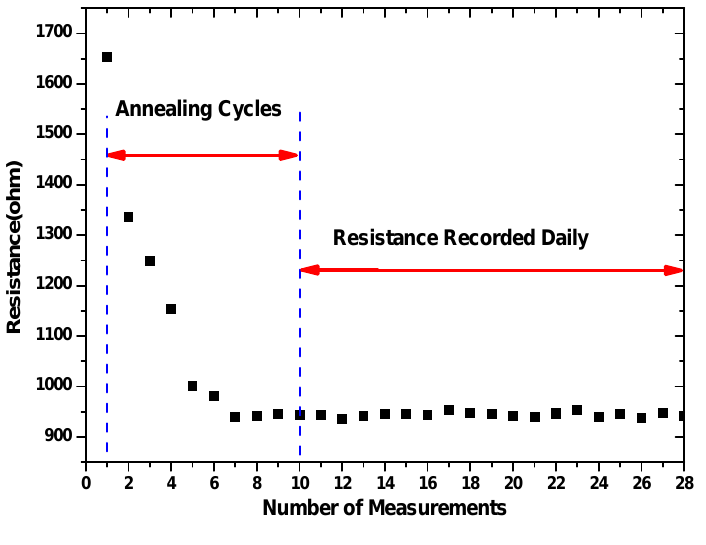
Figure 3. Room-temperature resistance of a MWCNT network during ten repeated annealing cycles and the resistance recorded daily after